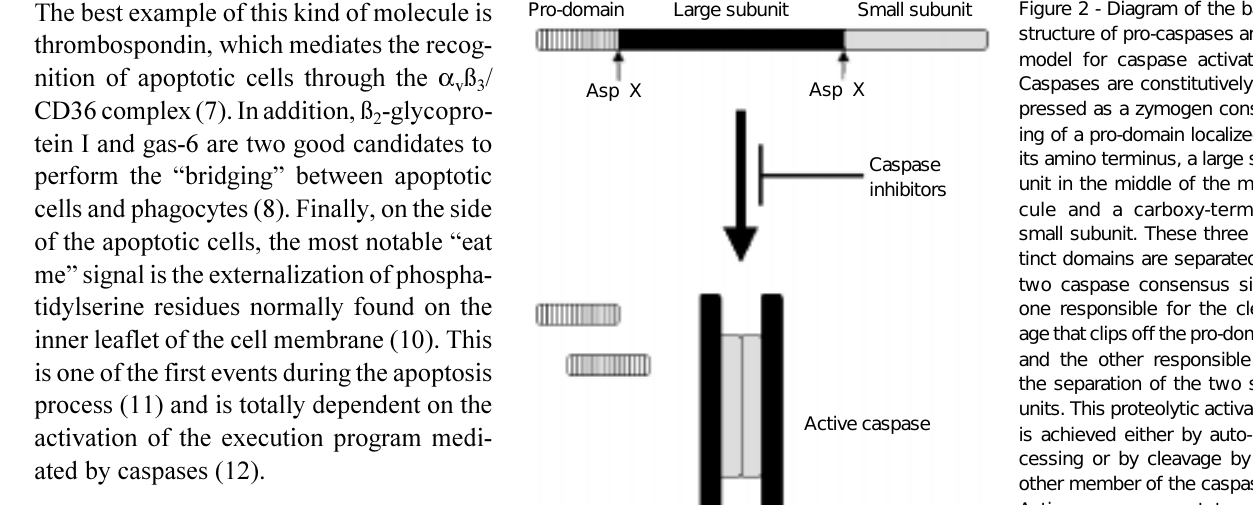
Figure 2 - Diagram of the basic structure of pro-caspases and a model for caspase activation. Caspases are constitutively ex- pressed as a zymogen consist- ing of a pro-domain localized at its amino terminus, a large sub- unit in the middle of the mole- cule and a carboxy-terminal small subunit. These three dis- tinct domains are separated by two caspase consensus sites, one responsible for the cleav- age that clips off the pro-domain and the other responsible for the separation of the two sub- units. This proteolytic activation is achieved either by auto-pro- cessing or by cleavage by an- other member of the caspases. Active caspases are tetrameric molecules formed by the asso- ciation of two heterodimers and therefore contain two independ- ent catalytic